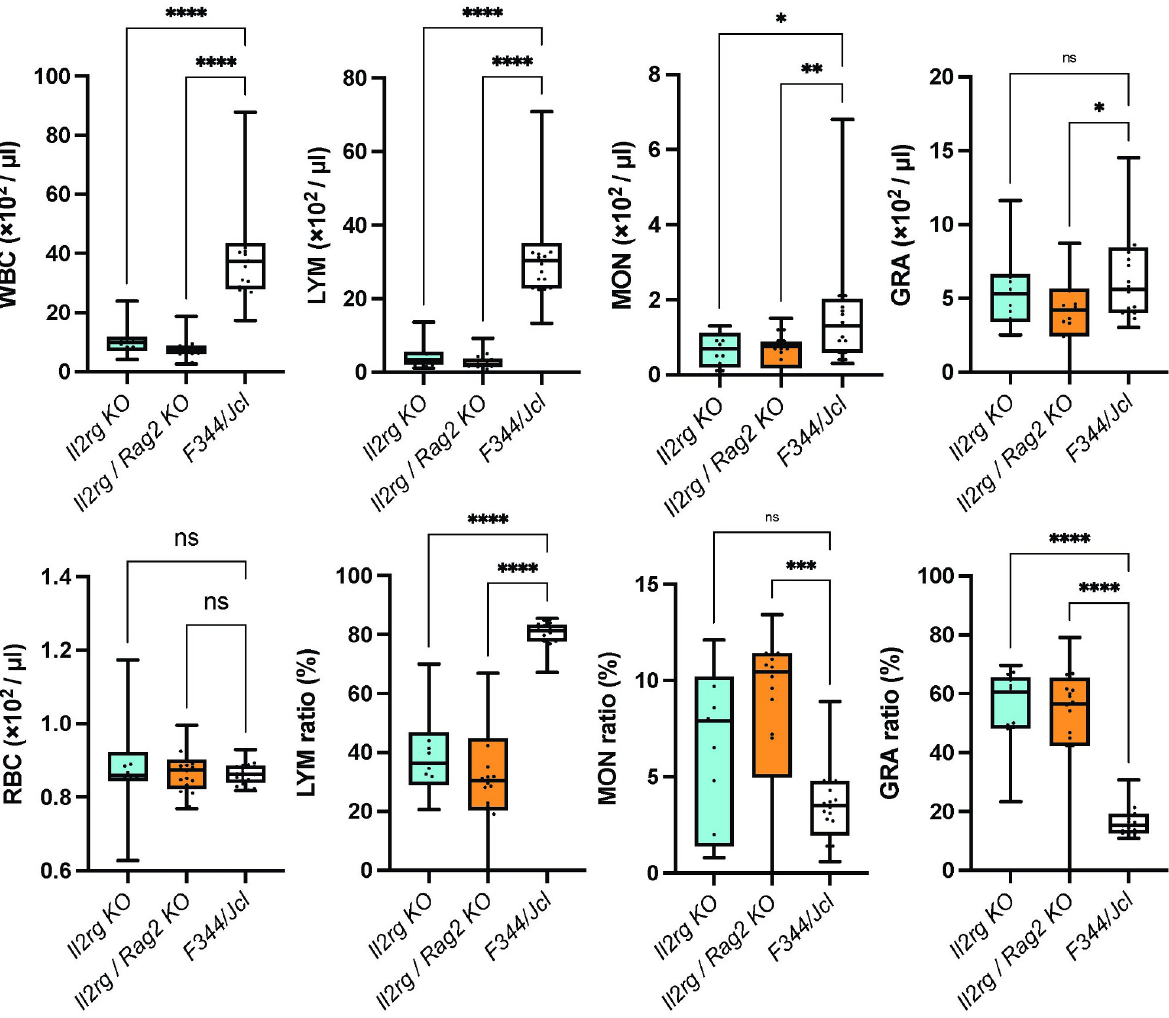
Fig 3. Analysis of hematological parameters. (A) Numbers of white blood cells (WBCs) and red blood cells (RBCs) in wild-type (WT), single- knockout (sKO), and double-knockout (dKO) rats. (B–D) Numbers of lymphocytes (LYM), monocytes (MON), granulocytes (GRA), and their ratios relative to all blood cells. The threshold of statistical significance was set at p = 0.0167 (Bonferroni correction of p = 0.05/3). WT, n = 20; sKO, n = 13; dKO, n =